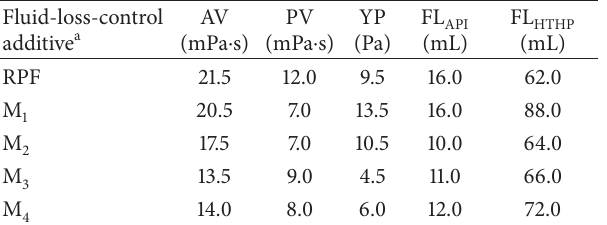
Table 5: Properties of RPF compared to commercial fluid-loss- control